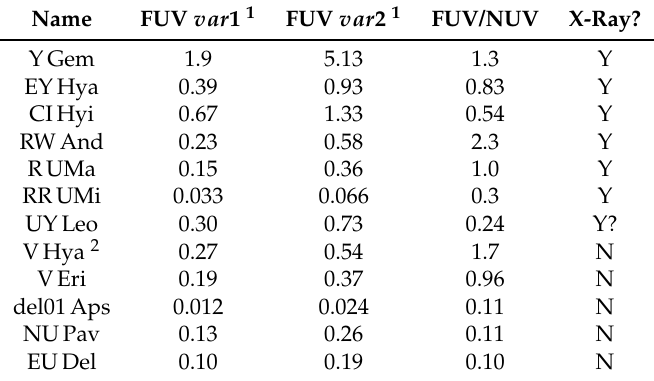
Table 1. UV Variability and X-Ray Emission of fuvAGB